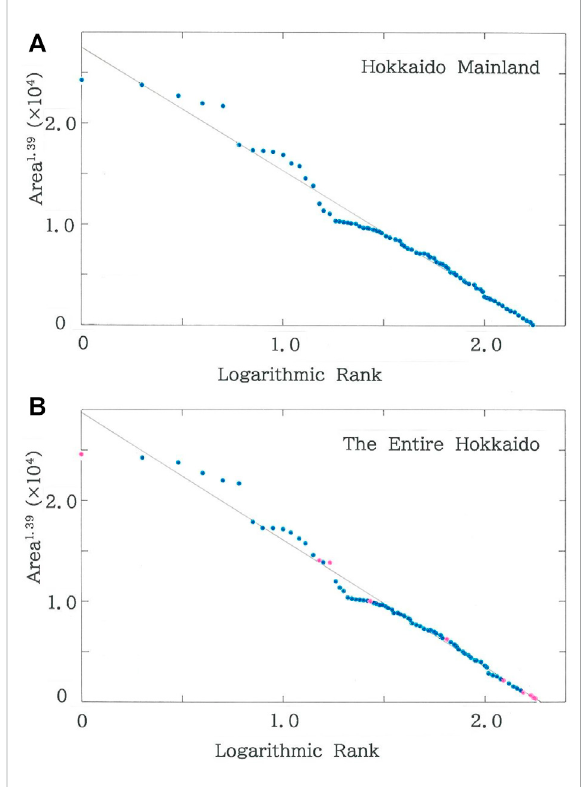
FIGURE 2 (A) Dependence of the areas (km 2 ) of municipalities in the mainland of Hokkaido on the logarithmic rank. The brown declining line indicates the optimized fi t (| r | = 0.9938 with d = 0.477for q =1.39 and n = 175; a = 2.75×10 4 , b =1.22×10 4 ). (B) Dependence of the areas (km 2 ) of municipalities in the entire Hokkaido on the logarithmic rank. The brown line indicates the optimized fi t (| r | = 0.9942 with d = 0.511 for q = 1.39 and n = 185; a =2.88×10 4 , b =1.26×10 4 ).Dataofmunicipalitiesontheterritorial islands are highlighted with pink dots.